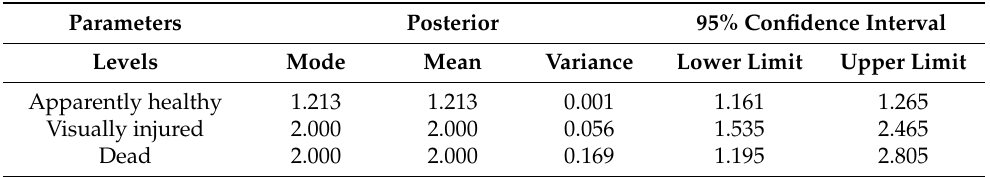
Table 7. Summary of the descriptive statistics of the posterior distribution for the factor status of the predator at the end of the hunting interaction.